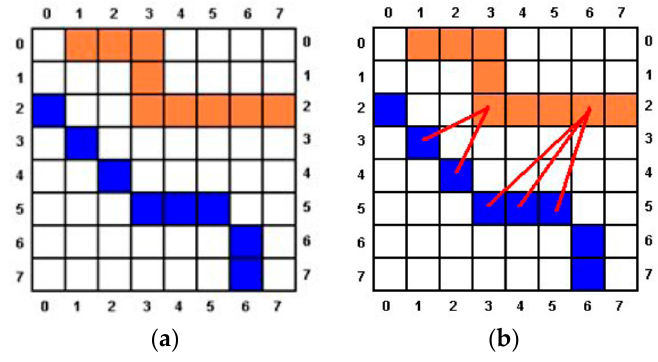
( g ) Figure 8. ( a ) Hieroglyph from a database to be used as a reference; ( b – d ) Hieroglyphs extracted from several cartouches; ( e – g ) Overlapped images. Step 8. First, the width of the hieroglyph is considered to be 8/10 of the width of the image, keeping the aspect rate. A hieroglyph is extracted when at least T % of the points of the hieroglyph’s contour satisfy that: (a)